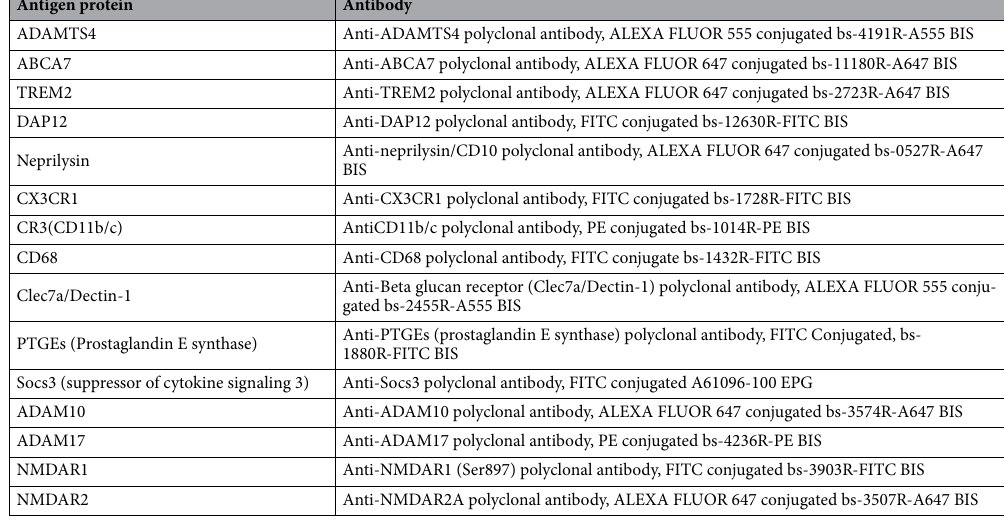
Table 2. Antibodies used for flow